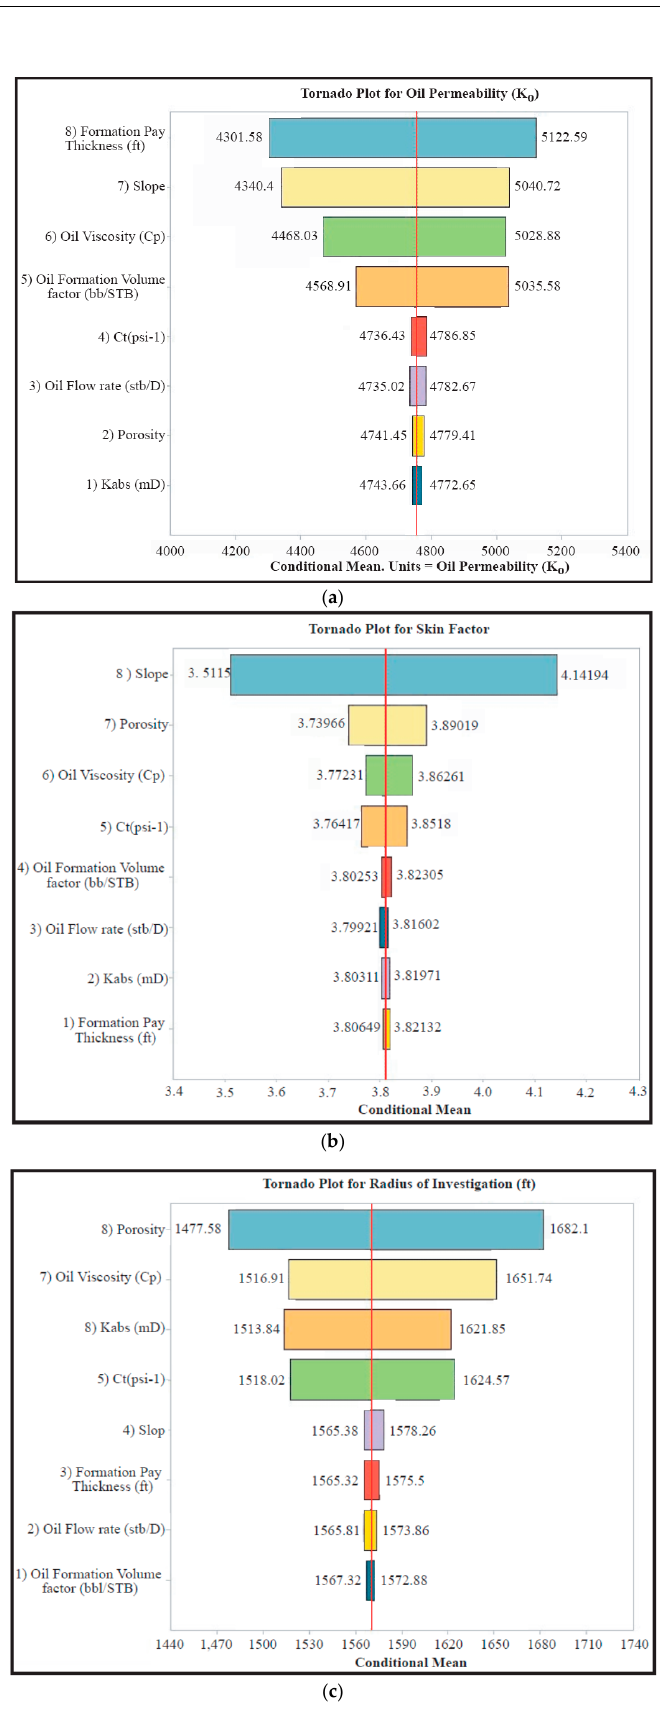
Figure 6. The Tornado plots for oil permeability ( a ), radius of investigation ( b ), and skin factor ( c ) calculations in well ND-1. Table 7. The error analysis results for all wells under full probability region (P0 to P100).